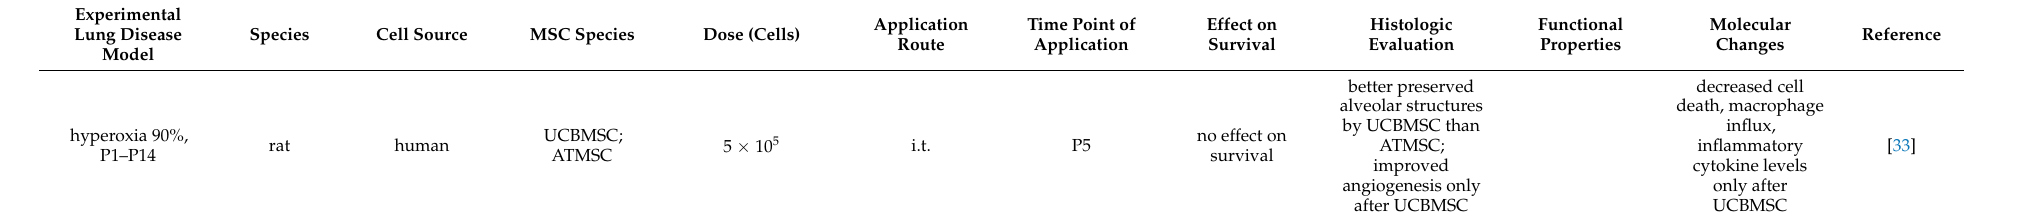
Table 4. Comparison of different stem cell preparations in BPD animal